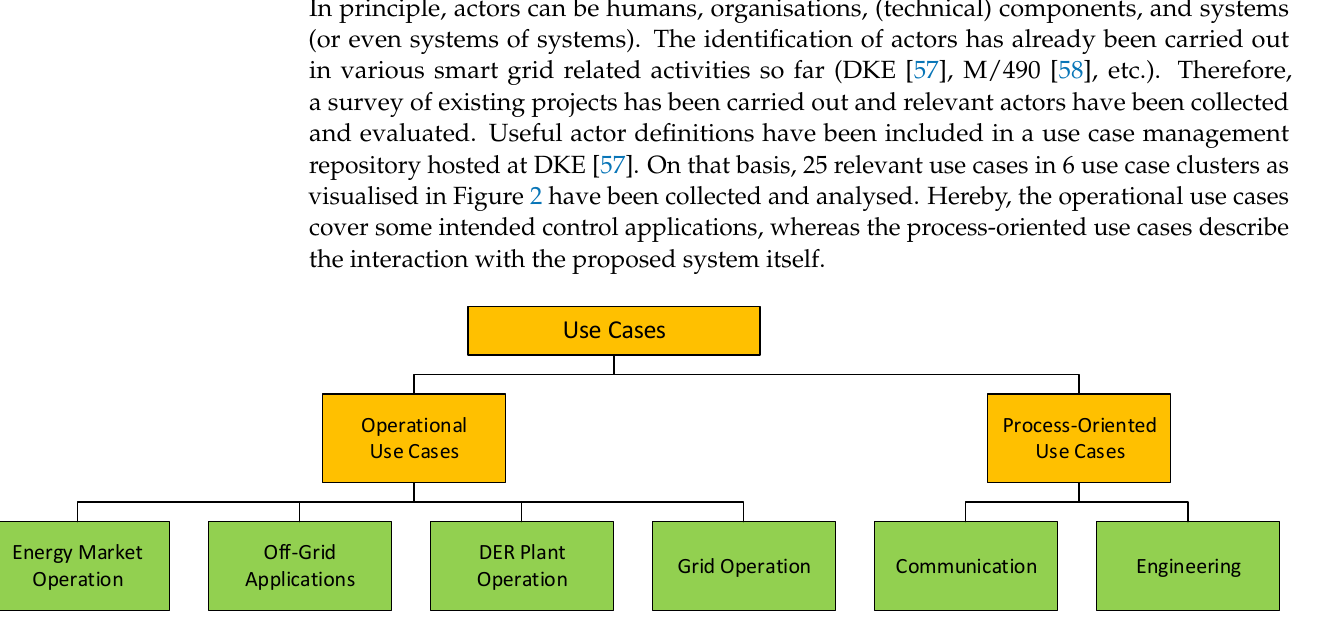
Figure 2. Overview of identified use case